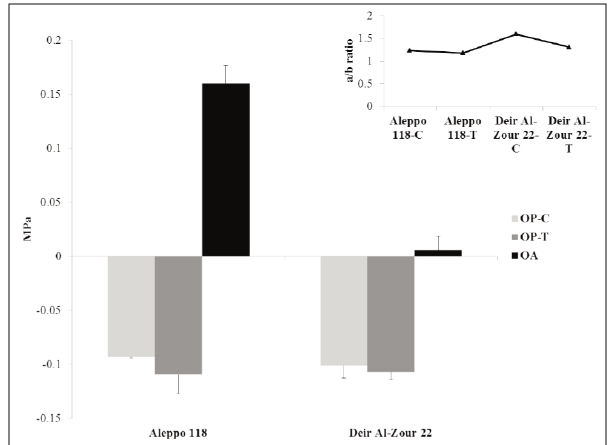
Fig. 1 - The inset graph is chlorophyll a/b ratio in leaves of con- trol (C) and treated (T) ‘Aleppo 118’ and ‘Deir-Al Zour 22’ plants. Main graph represents osmotic potential and osmotic adjustment in leaves of control and treated ‘Aleppo 118’ and ‘Deir Al-Zour 22’ plants. Plants were under drip irrigation system, where the control plants were given full irrigation each week, and treated plants have been given deficit irrigation each 10 days. Data represent means and standard error of three replica- tions.